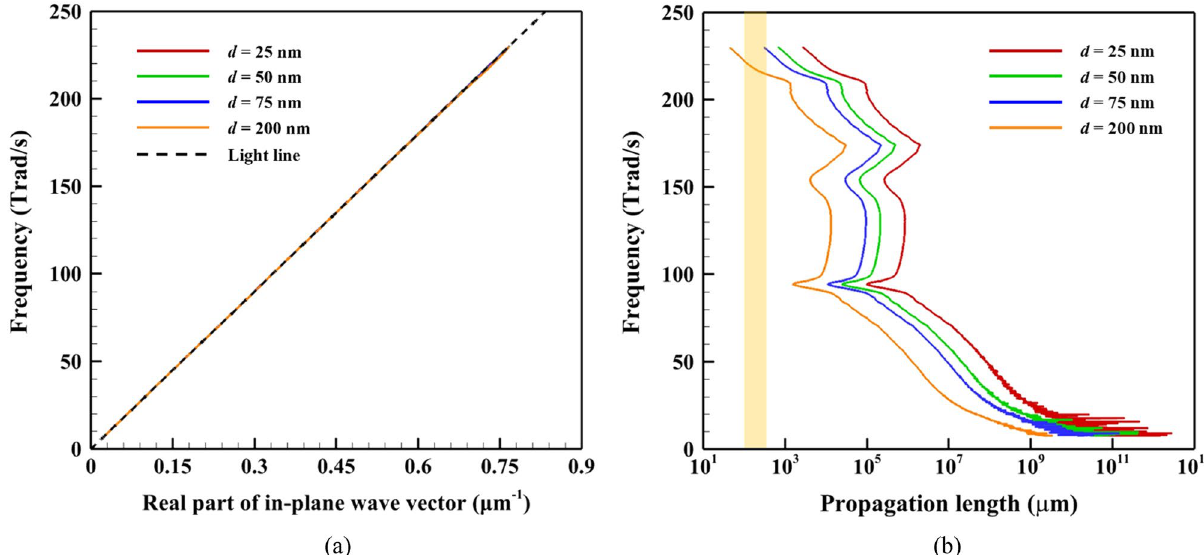
Figure 3. ( a ) Dispersion relation; ( b ) propagation length of the SPhPs on the amorphous SiO 2 film surface of various thicknesses. The yellow area corresponds to the range of the film length used in this